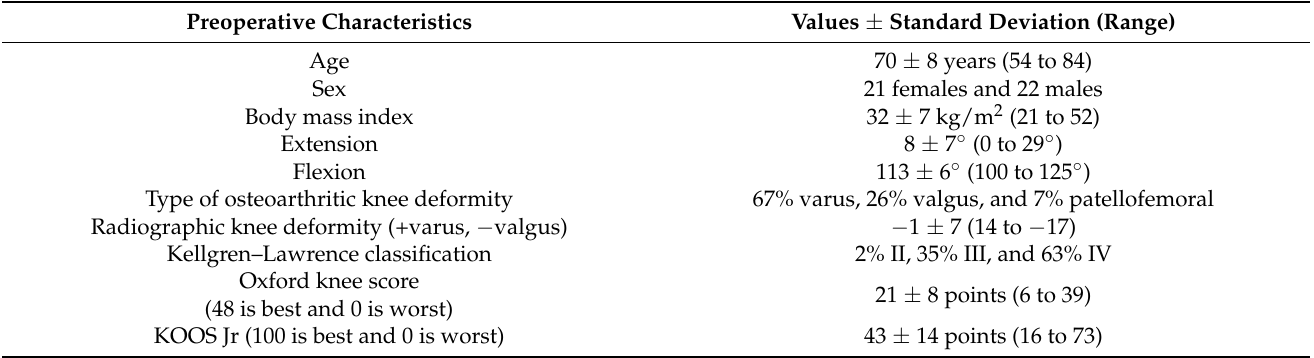
Table 1. Preoperative characteristics, knee conditions, and function scores for the 43 patients in the present